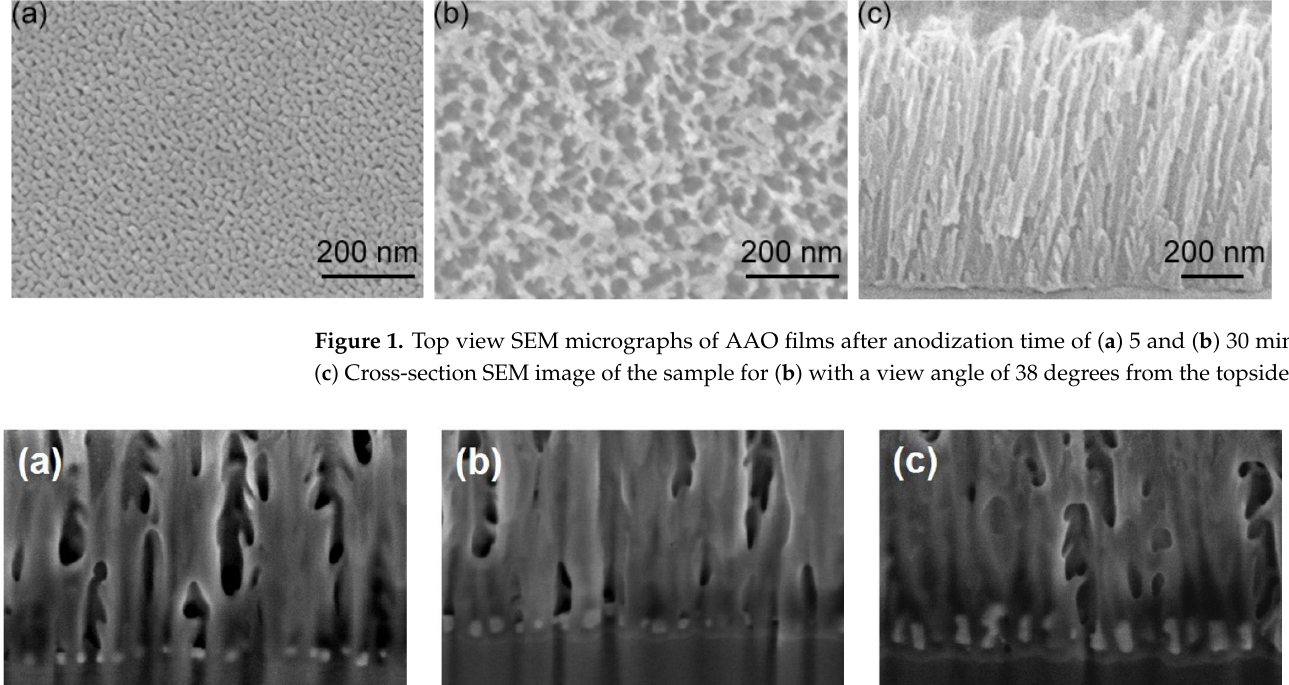
Figure 1. Top view SEM micrographs of AAO films after anodization time of ( a ) 5 and ( b ) 30 min. ( c ) Cross-section SEM image of the sample for ( b ) with a view angle of 38 degrees from the topside.